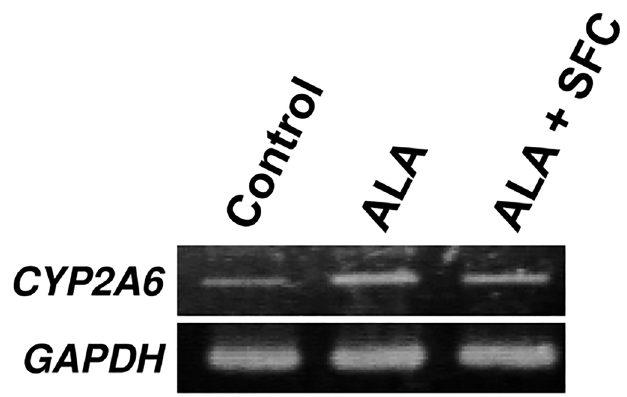
Fig 1. Expression level of CYP2A6 mRNA. CYP2A6 mRNA levels were determined by RT-PCR after incubating MKN28 cells with 1.0 mM ALA, 0.5 mM SFC, or both for 8 h. GAPDH is used as internal